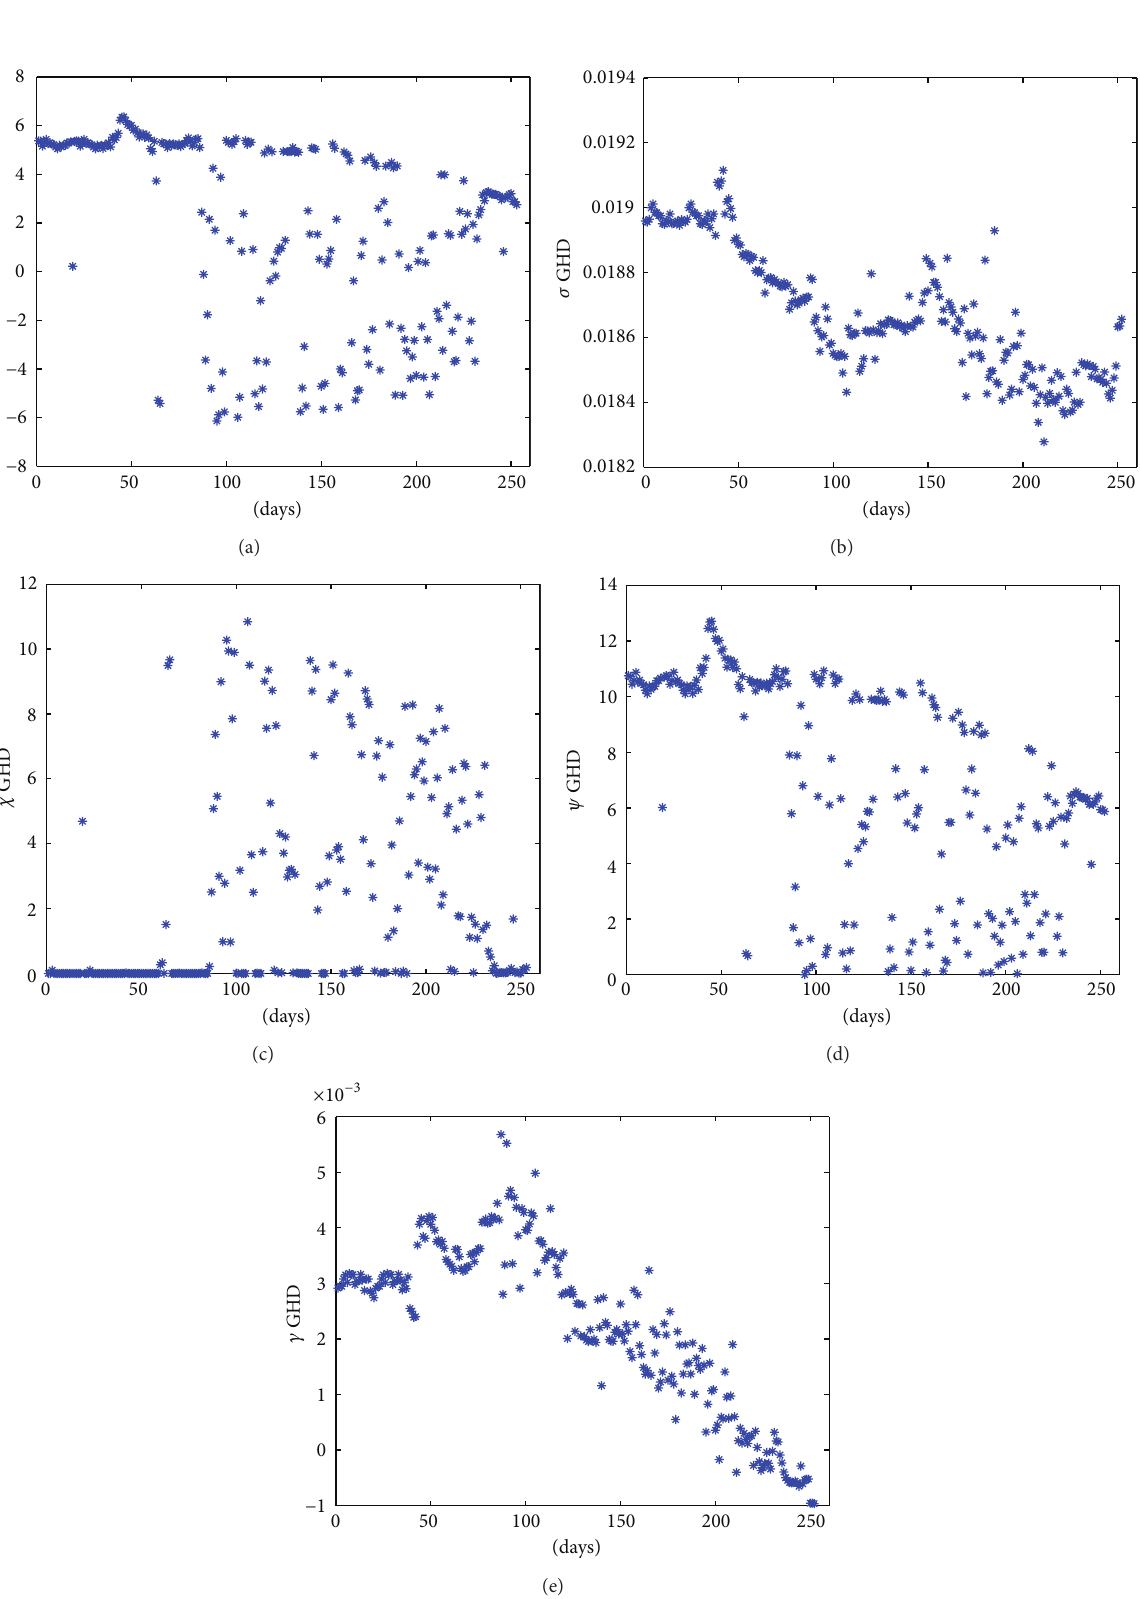
Figure 2: Daily variation of 𝜆 , 𝜎 , 𝜒 , 𝜓 , and 𝛾 for AGL with